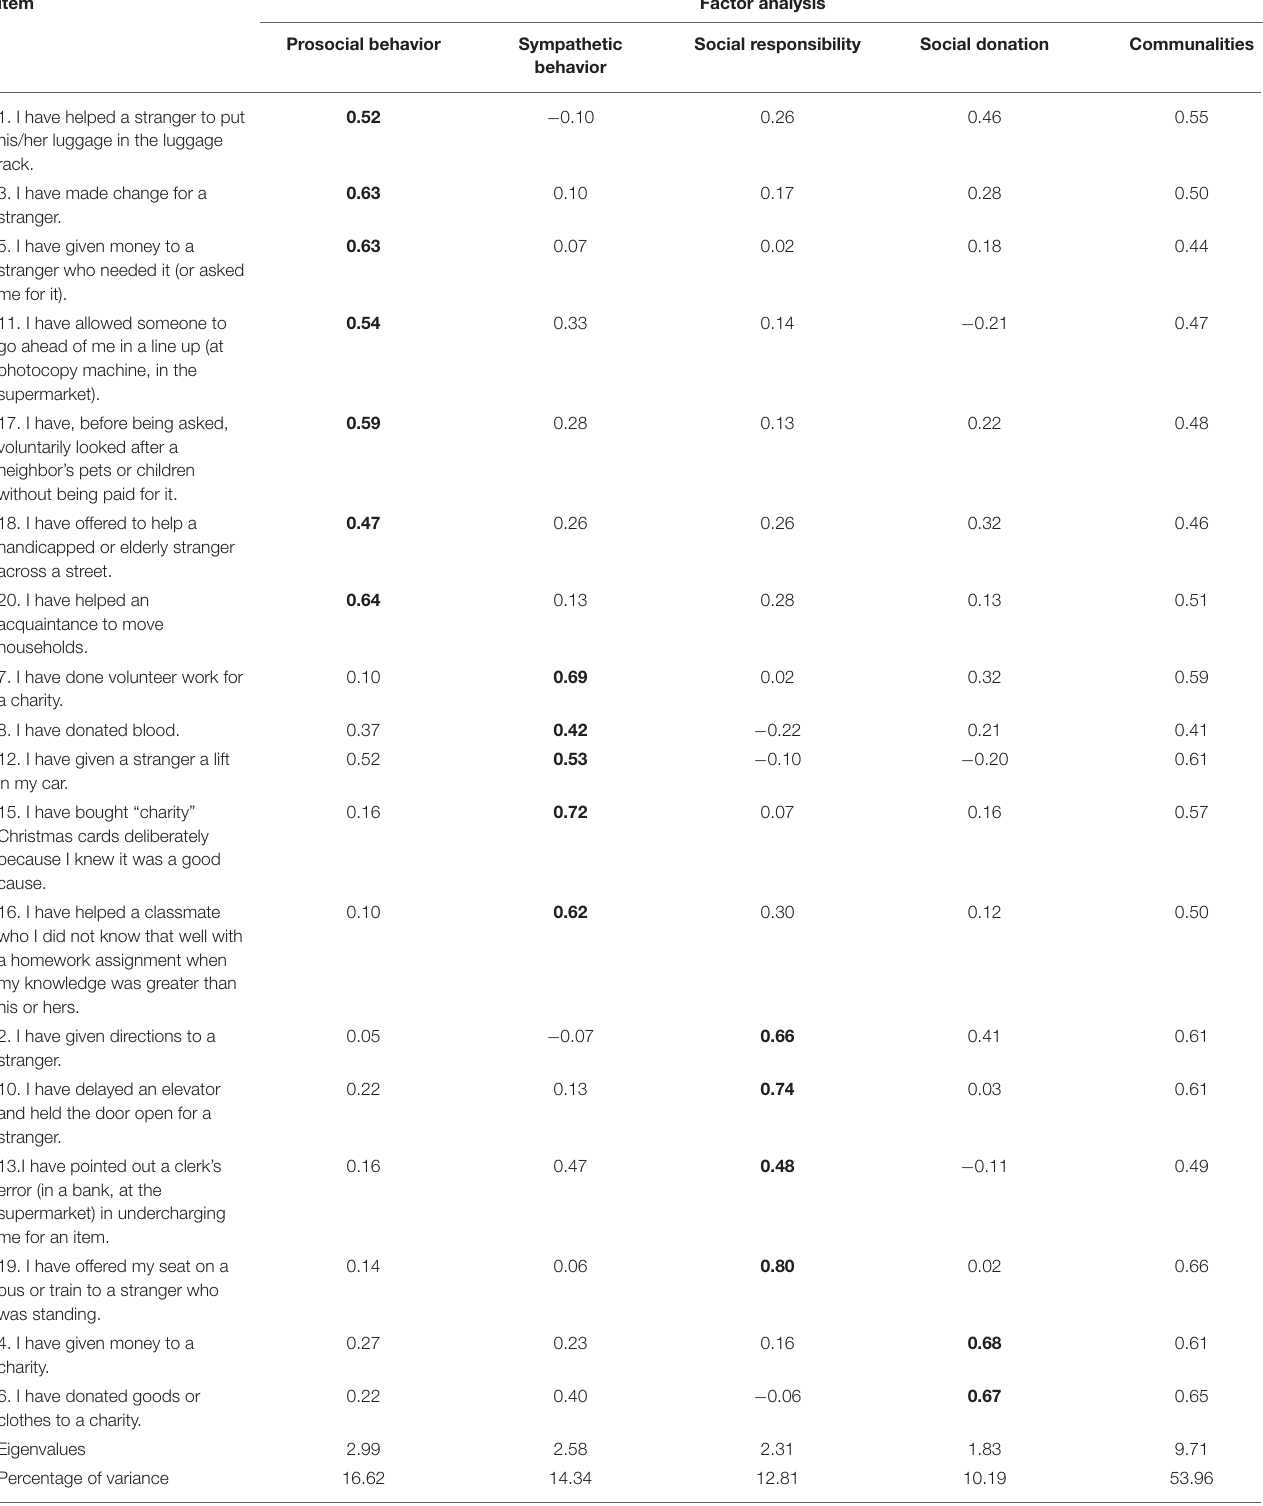
TABLE 1 | Factor analysis of altruism.